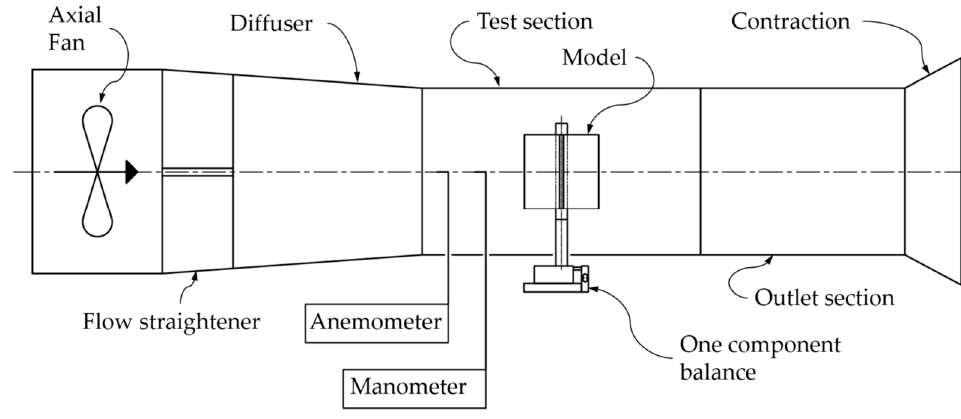
Figure 2. Schematic diagram of the test stand.